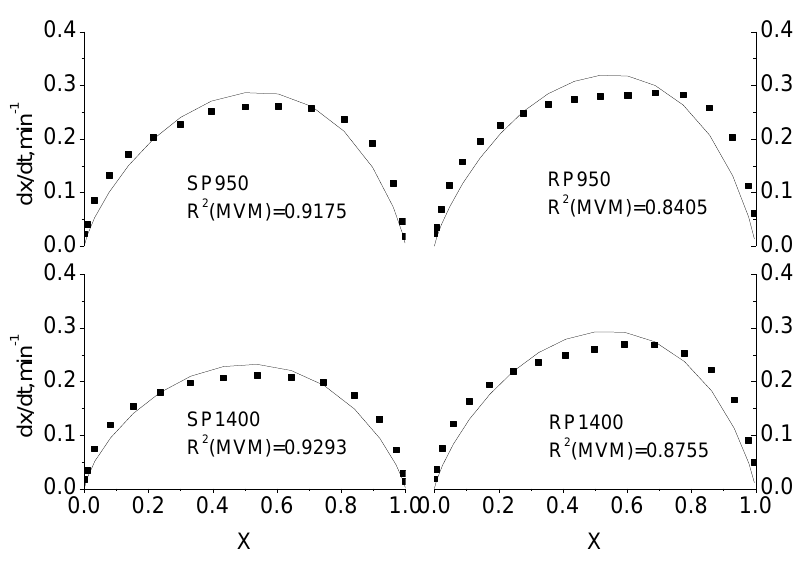
Figure 4. Reaction rate versus carbon conversion for coal char gasification at the gasification temperature of 1,400 °C. Experimental data ( ■ ); MVM